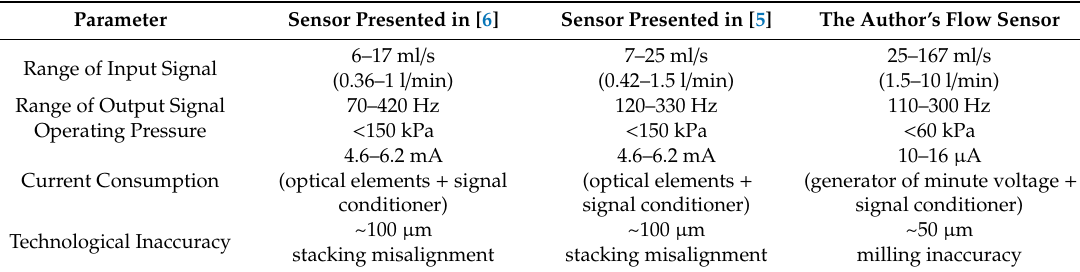
Figure 6. Sensor examination: ( a ) Averaged value of output signal spectrum at 5 l/min; ( b ) Calibration curve; Q — flow rate; f out — frequency of output signal. Table 2. Parameter comparison of Low Temperature Co-fired Ceramic (LTCC) turbine-based flow sensors.